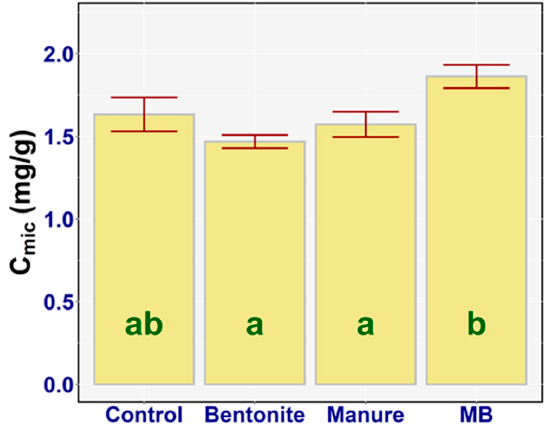
Figure 7. C mic (mg / g) of the treatments: means with SEM. Figure 7. C mic (mg/g) of the treatments: means with SEM.